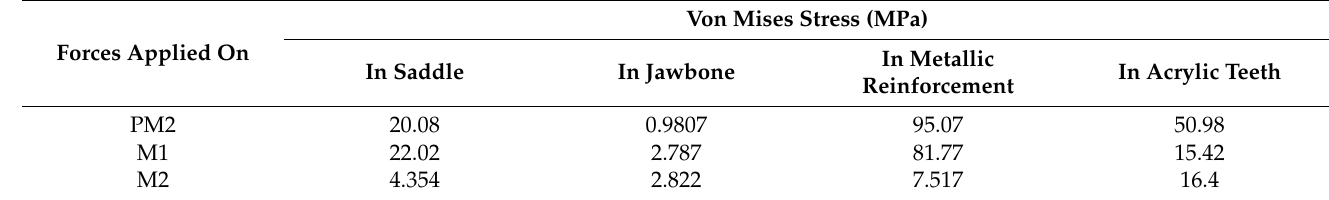
Table 3. The maximum von Mises stress (MPa) for the unilateral RPD.